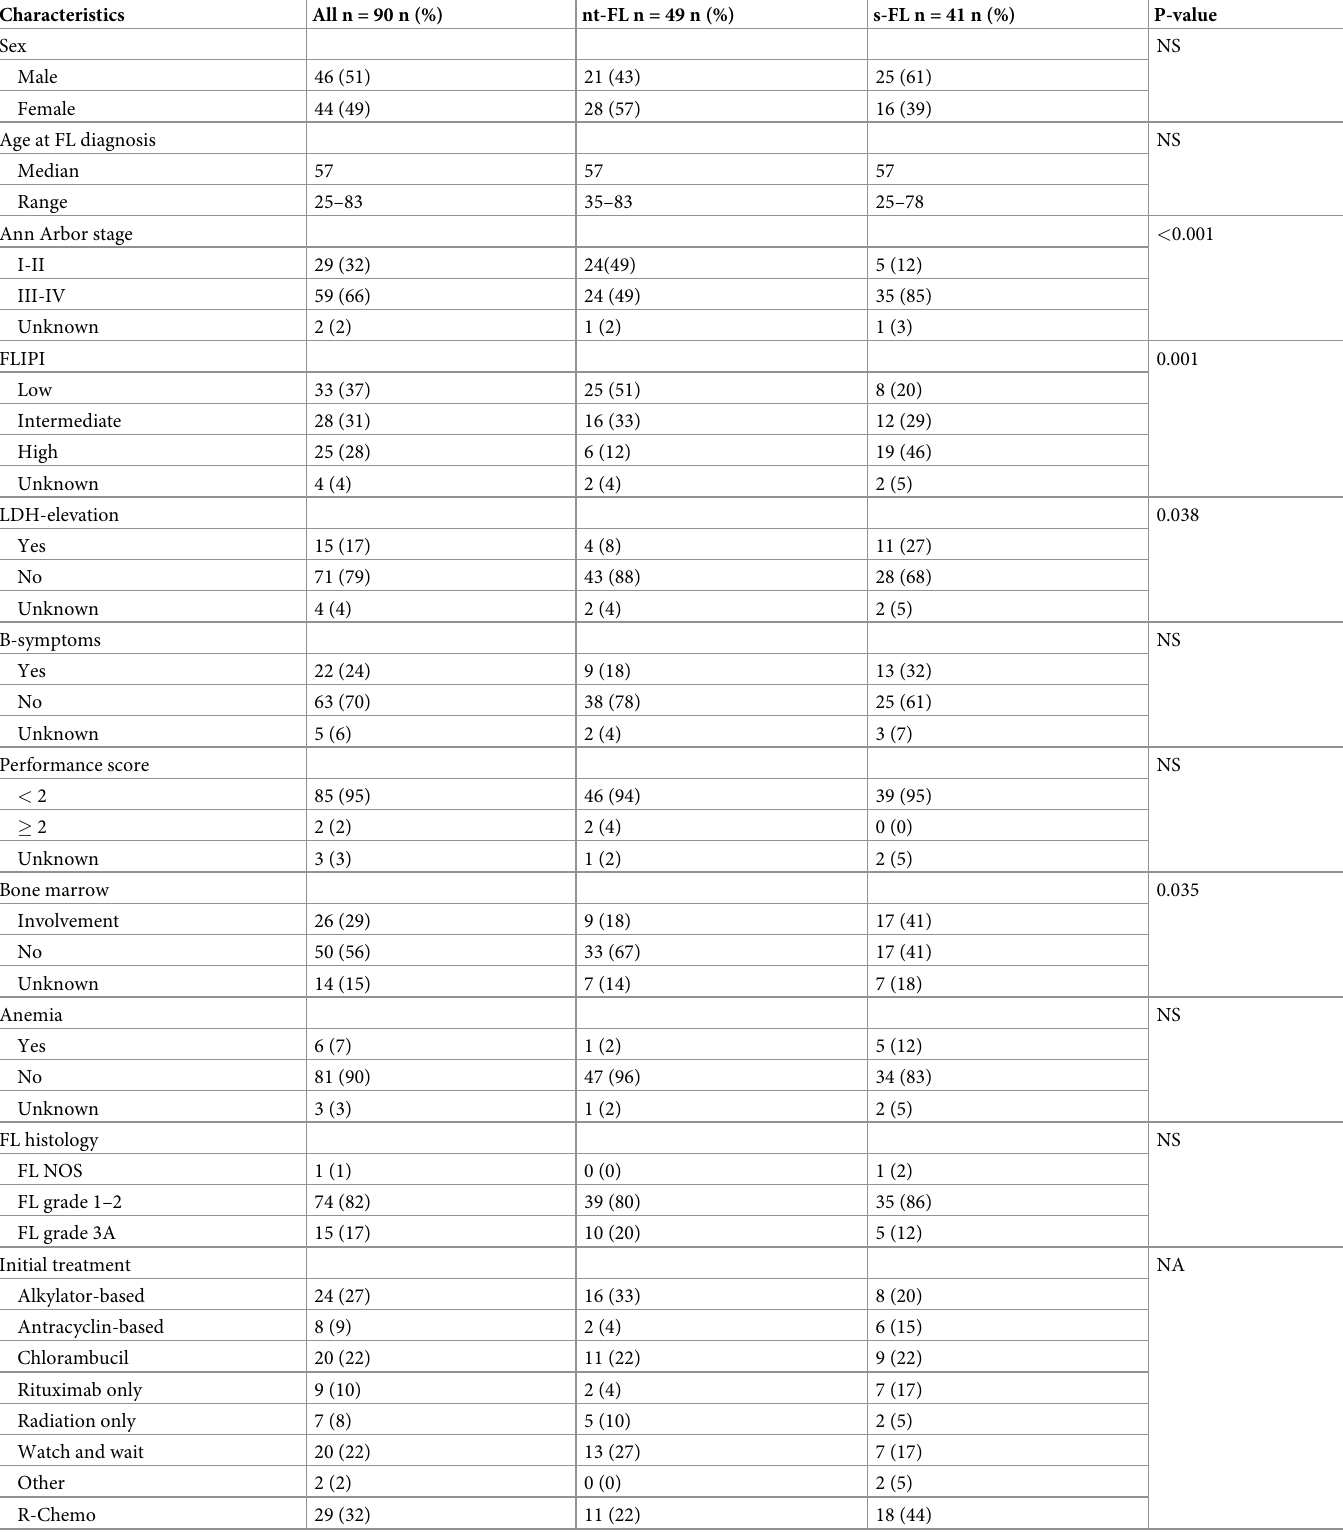
Table 1. Clinico-pathological